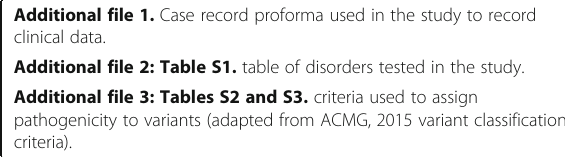
Additional file 2: Table S1. table of disorders tested in the